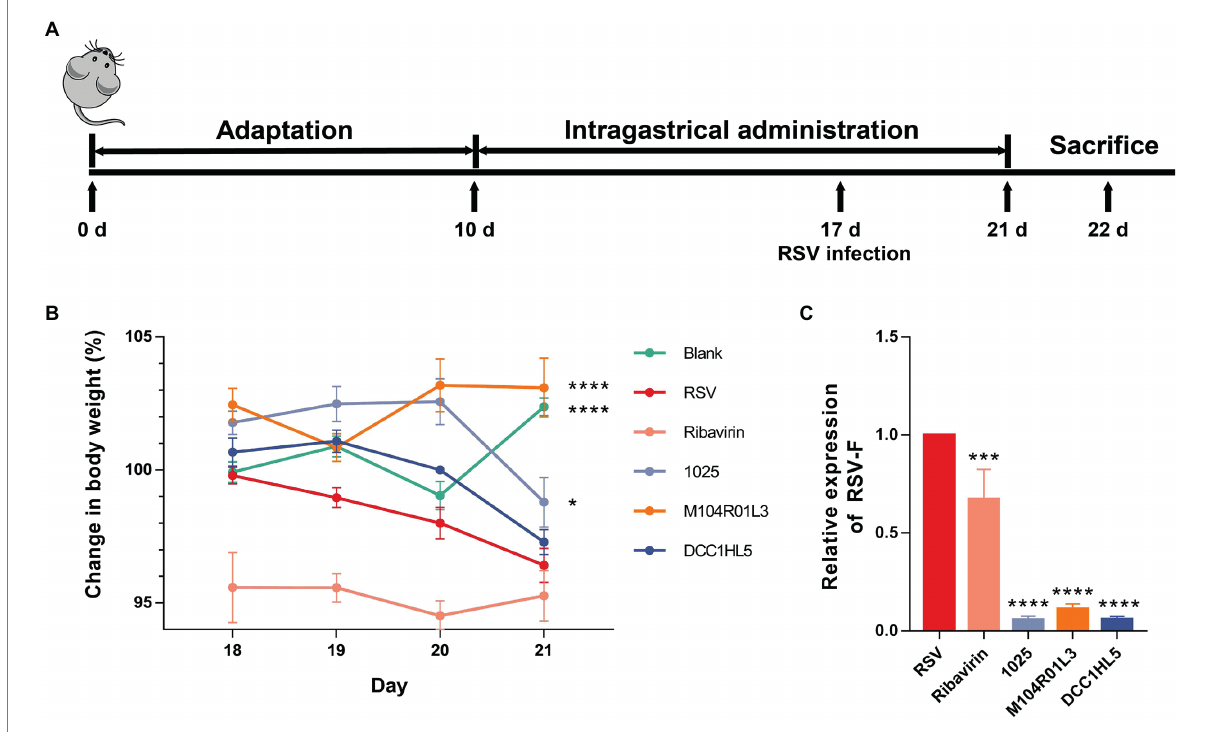
FIGURE 1 Effects of three Lactobacillus mucosae strains on weight loss and viral load in a mouse model of respiratory syncytial virus (RSV) infection. (A) Timeline of administering three L. mucosae strains to mouse models and infecting them with RSV. (B) Changes in body weight of mice. The calculation of the weight change of each mouse was taken their weight of Day 17 as the baseline. (C) Viral load in lung tissues ( n = 8; * p < 0.05, *** p < 0.001, **** p < 0.0001 vs. RSV group). Error bars indicate the means ± standard error of the mean (SEM). Differences were compared using one-way ANOVA, followed by Fisher’s LSD tests. P -values were adjusted using a false discovery rate. Blank, not infected with RSV. RSV, infected with respiratory syncytial virus and